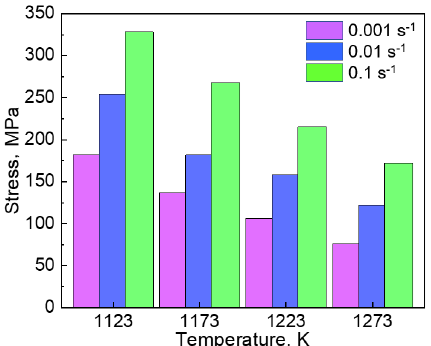
Figure 2. The true stress-strain curves of the Co 35 Cr 25 Mn 15 Ni 15 Fe 10 TRIP-HEA hot-compressed at ( a ) 1123 K, ( b ) 1173 K, ( c ) 1223 K, and ( d ) 1273 K. The strain rates were 0.1, 0.01, and 0.001 s −1 .